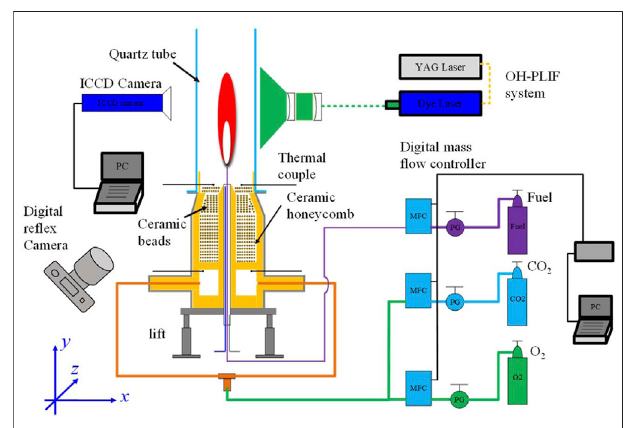
FIGURE 1 | Schematic of the experimental